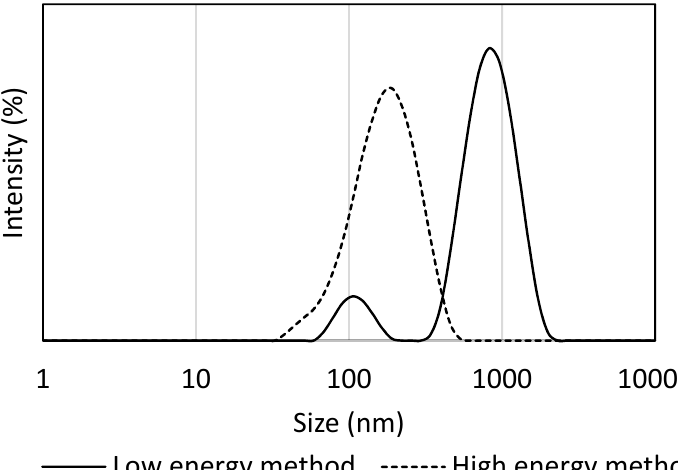
Figure 2. Particle size distribution recorded after emulsification with low-energy vs. high-energy conditions at emulsions with 5 wt % Tween 80/Span 80 and HLB 9. The Tween 80/Span 80 ratio was 0.78.